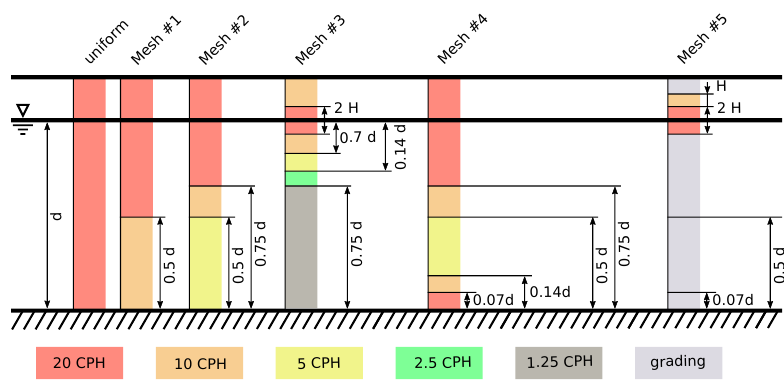
Figure 9. Examples of different meshes using varying refinement layers along the water column: Different colours mark different mesh sizes, parameterised by the wave height (Schematic not at scale).